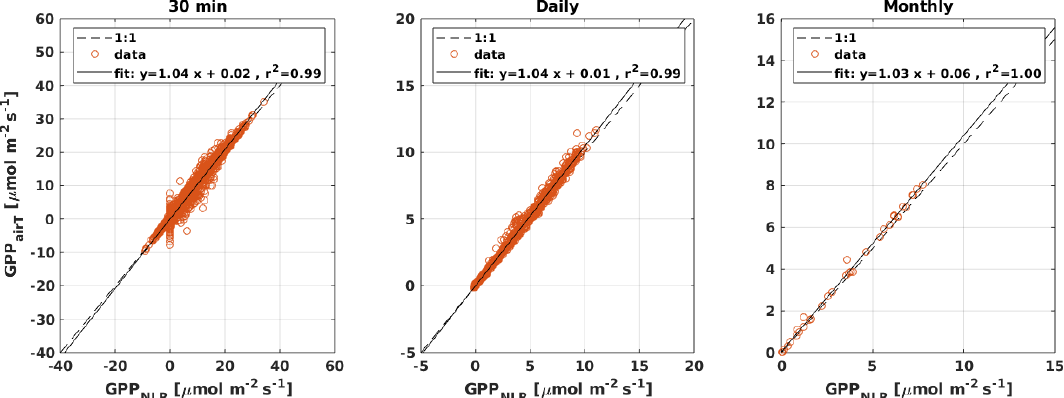
Figure B3. Scatter plots of GPP airT that uses only air temperature as the driver for respiration against GPP NLR that uses an average of air and soil temperatures as the respiration driver at 30min, daily, and monthly timescales. The solid black line is the least-squares linear fit to the data.